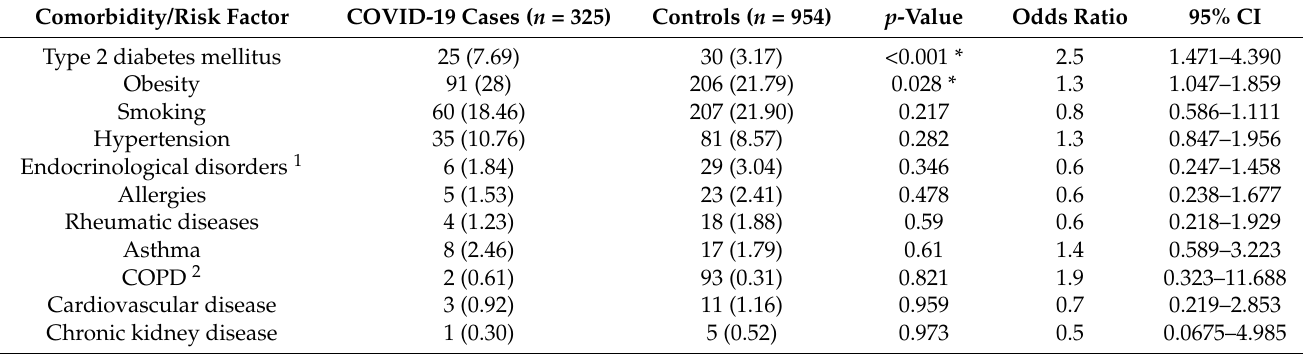
Table 1. Main findings observed in the study population categorized by COVID-19 cases and controls.